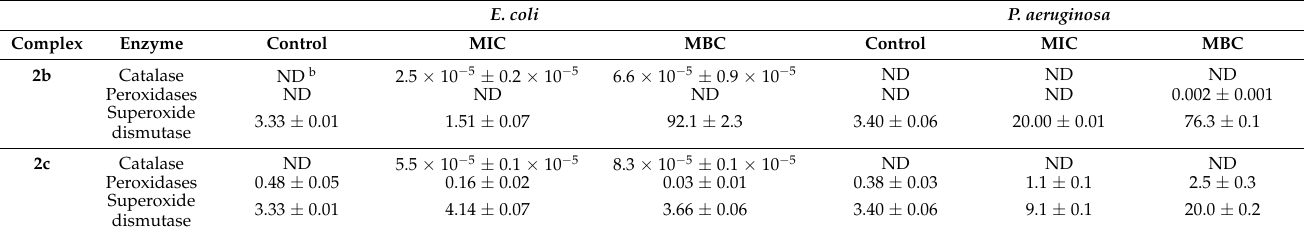
Table 2. Antioxidant enzyme activity (mU · mg − 1 protein) of complexes 2b and 2c in E. coli and P. aeruginosa assays a